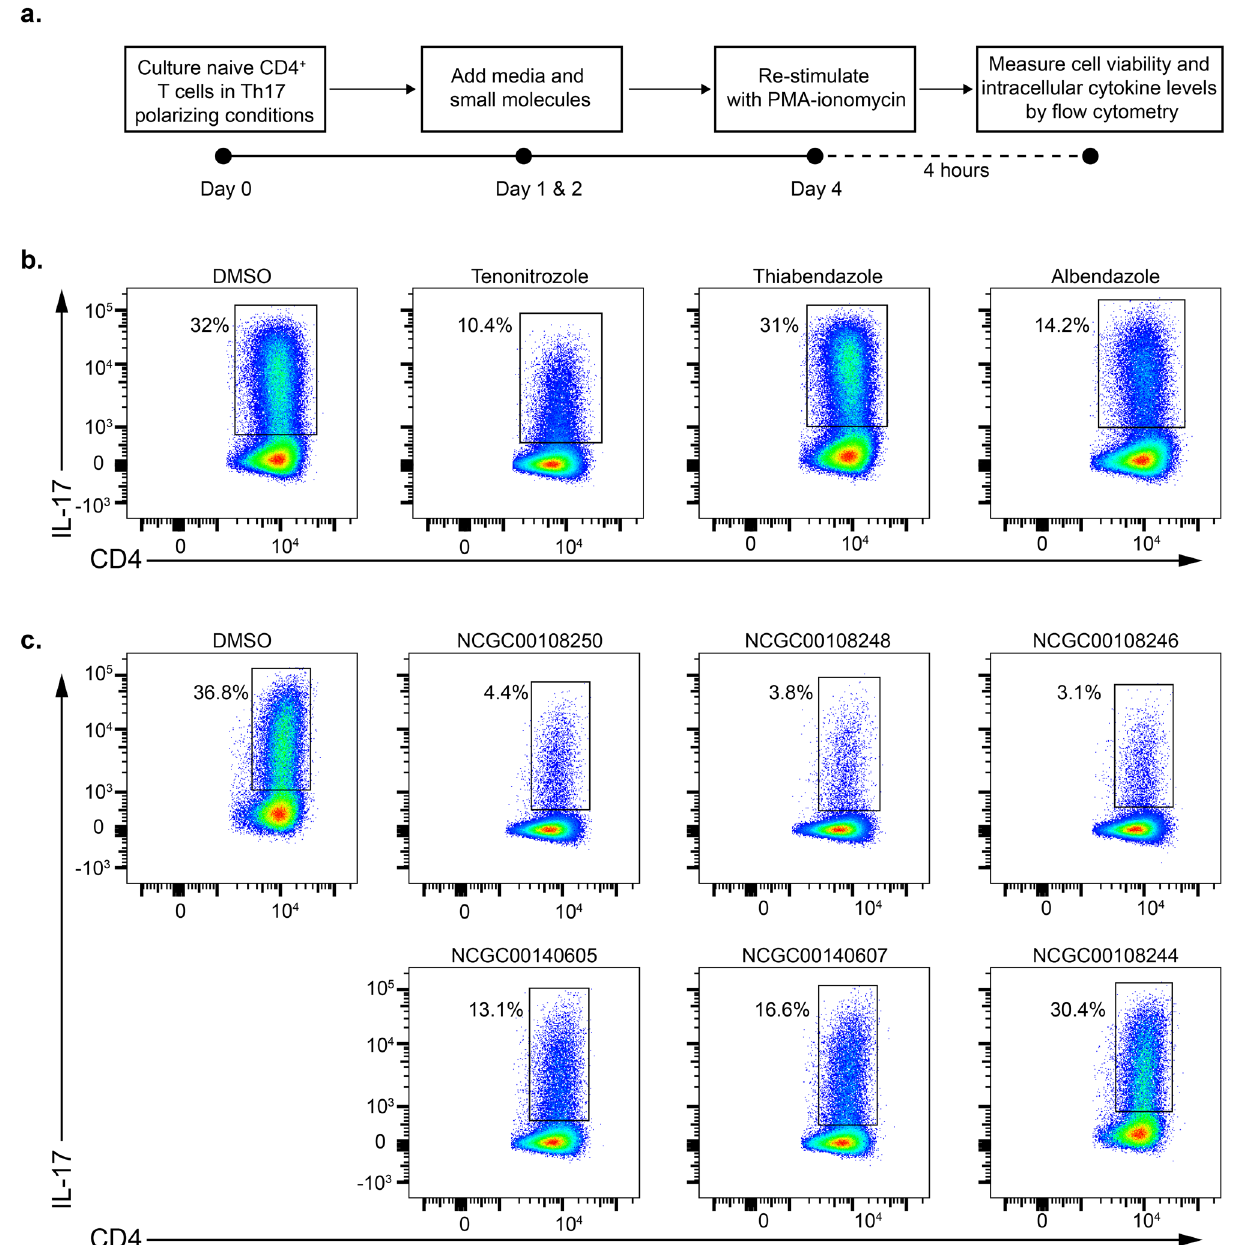
Figure 3. Validation of hit compounds using functional IL-17 producing assay. Naïve CD4 + T cells from spleens and lymph nodes of C57BL/6 mice were differentiated under Th17 polarization conditions and were treated with DMSO (control) or the indicated compounds: ( a ) Schema for testing hit compounds in intracelIular IL-17 cytokine (flow cytometry) assay. ( b ) Flow cytometric plots showing DMSO or compound (Tenonitrozole, Thiabendazole and Albendazole) treated cells at 20 µM stained for surface CD4 and intracellular IL-17. The plots are gated on live CD4 + CD44 high cells. ( c ) Flow cytometric plots showing DMSO or compound (NCGC00108250, NCGC00108248, NCGC00108246, NCGC00140605, NCGC00140607, NCGC00108244) treated cells (at 20 µM) stained for surface CD4 and intracellular IL-17. The plots are gated on live CD4 + CD44 high cells. Data in panels b & c are representative of at least 3 independent (EC 50 = 3.7 µM) demonstrated dose-dependent inhibition of Mir155 reporter expression (Fig. 2c). These com- pounds were further evaluated for cytotoxicity using CellTiter-Glo (Fig. 2c). Validation of Hit Compounds Using Functional IL-17 Producing Assay. The two families of com- pounds, the three azoles and the chemical series of ( E )-1-(phenylsulfonyl)-2-styryl-1 H -benzo[ d ] imidazoles (imidazoles), inhibited Mir155 reporter expression under Th17 polarization conditions. It has been previously shown that IL-17 production is defective in miR-155 deficient cells 16 . Therefore, we expected to see the same